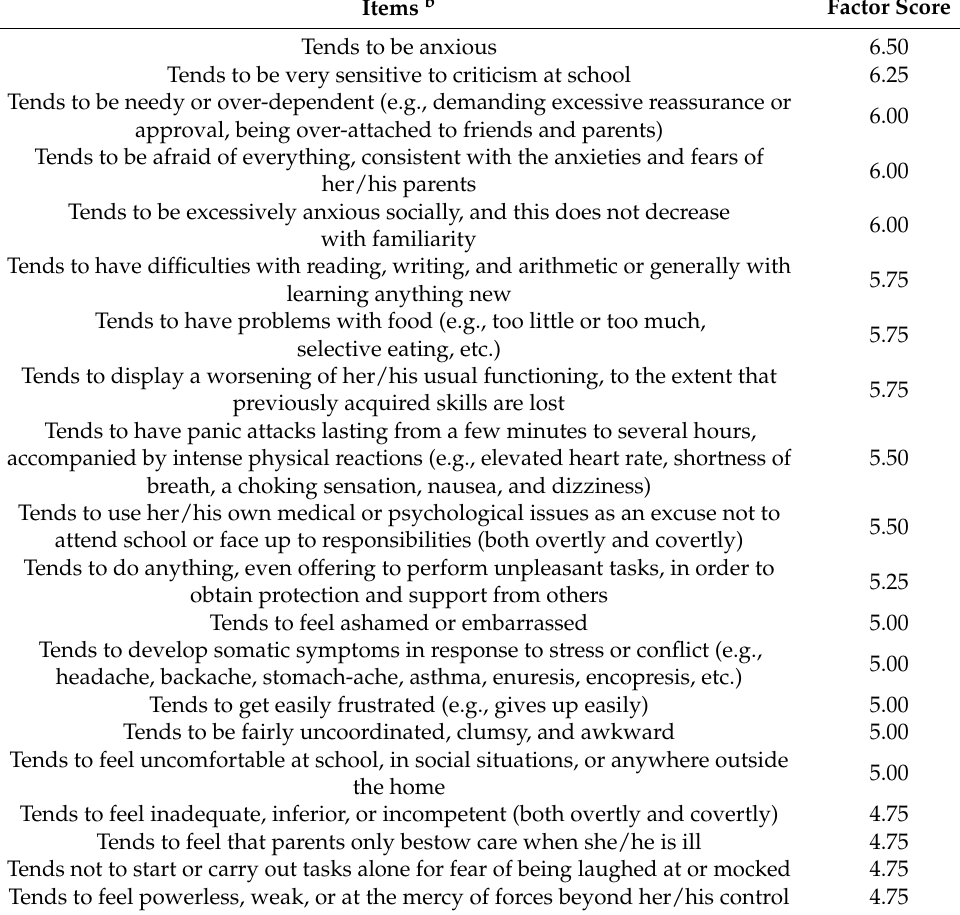
Table 7. Best CPAP-Q a items of the dysphoric/dependent prototype. Items b Factor Score Tends to be